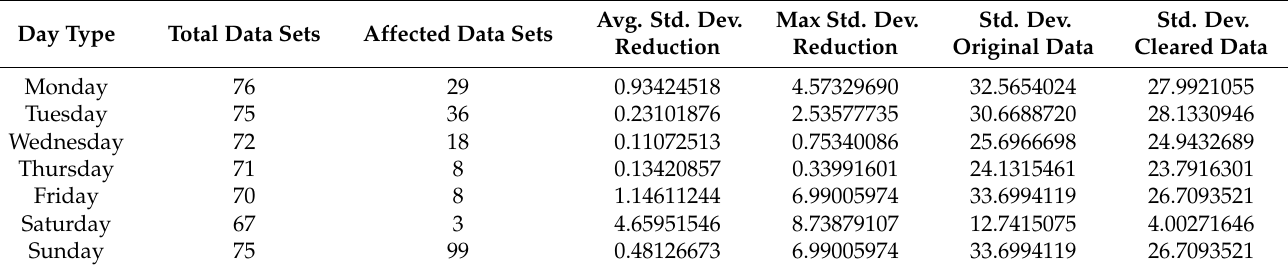
Figure 14. Daily consumption baseline for the original and cleared data sets. Table 10. Semester I baseline for original and cleared data sets.